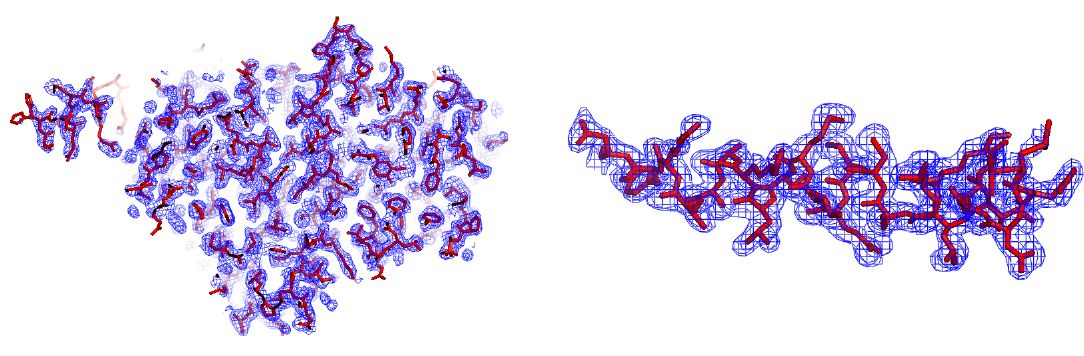
Figure 10. The calculated density map superimposed on the PDB model.